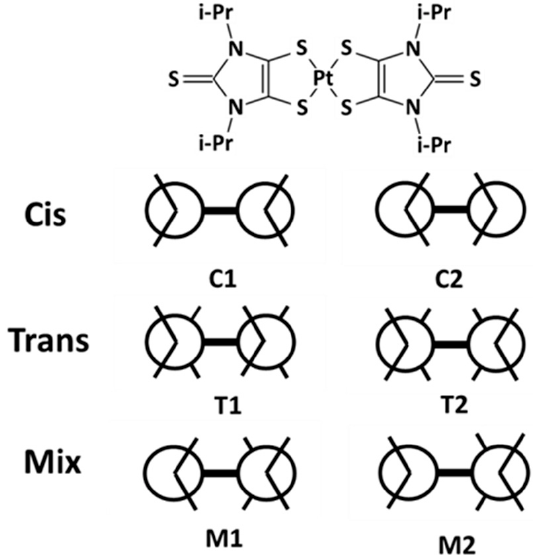
Figure 1. Chemical structures and Newman-like projections of [Pt(iPr 2 timdt) 2 ] complexes.